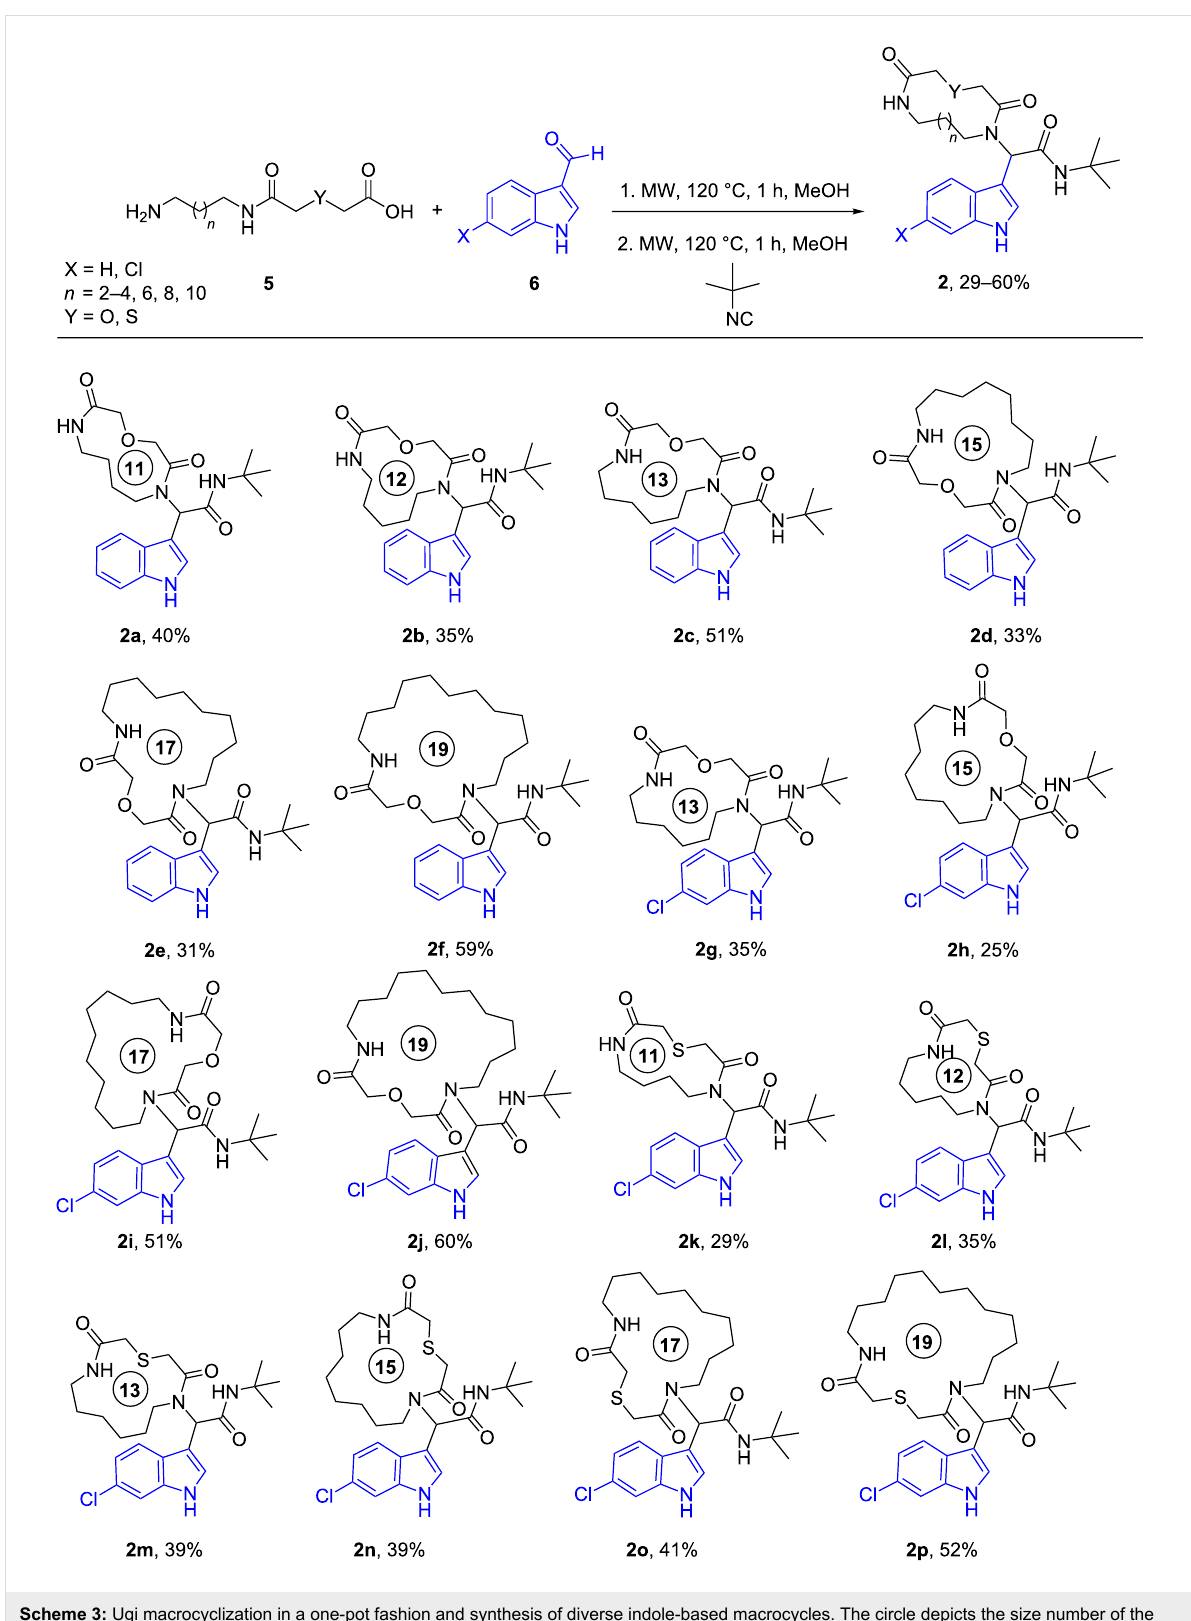
Scheme 3: Ugi macrocyclization in a one-pot fashion and synthesis of diverse indole-based macrocycles. The circle depicts the size number of the